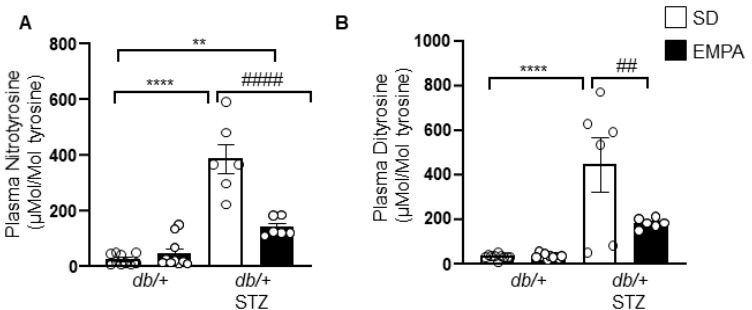
Figure 5. EMPA lowers systemic oxidative stress in T1D mouse model. ( A , B ) Plasma levels of nitrotyrosine ( A ) and dityrosine ( B ) in T1D ( db /+ STZ) and control ( db /+ ) mice with / without EMPA; n = 6–10 mice per group; ** p < 0.01, **** p < 0.0001 for untreated control vs. untreated T1D; ## p < 0.01, #### p < 0.0001 for untreated vs. treated T1D; by one-way ANOVA. Data are expressed as the mean ± s.e.m.